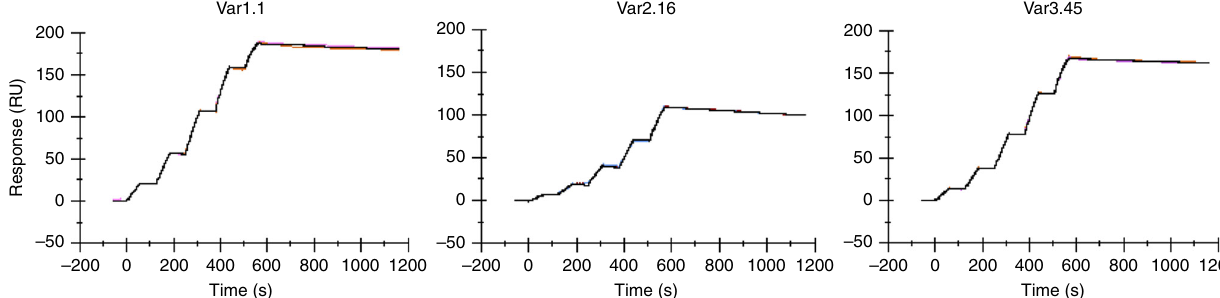
Fig. 1 mAb 1A12 shows high-af fi nity cross-reactive binding to fHbp in SPR studies. In each panel, sensorgrams show the experimental association and dissociation traces (colored) performed in duplicate for the binding of the different fHbp subvariants to captured mAb 1A12; the calculated fi tting traces are shown in dark gray. Full kinetic analyses of each interaction are reported in